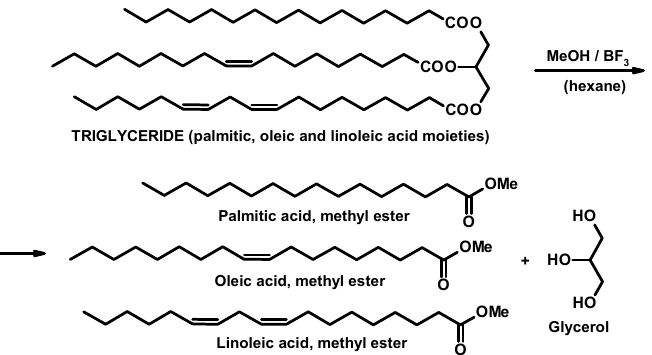
Figure 2. Schematic representation of the derivatization (transesterification) of a fatty acid glyceride (containing palmitic, oleic, and linoleic moieties) to the corresponding palmitic, oleic, and linoleic acid, methyl esters.